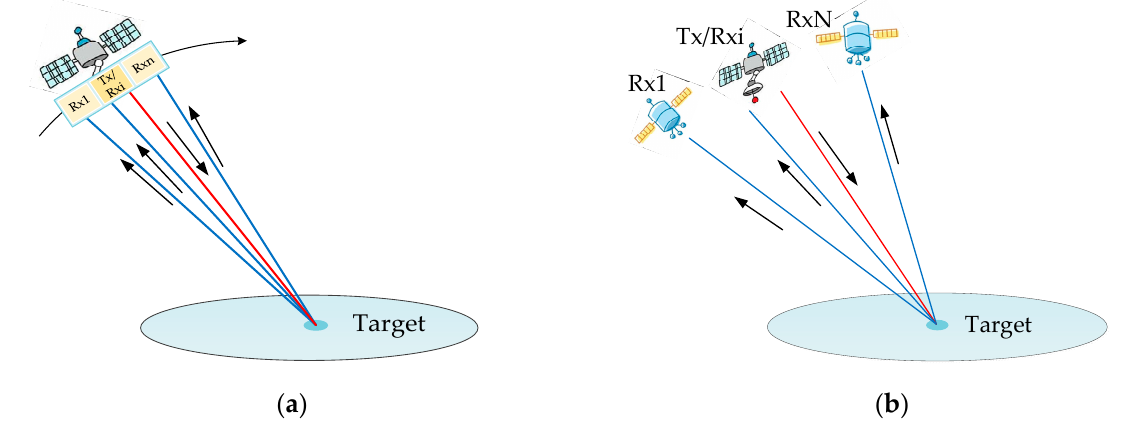
Figure 1. Spaceborne DPCMAB SAR. ( a ) The monostatic SAR system; ( b ) the distributed SAR system.